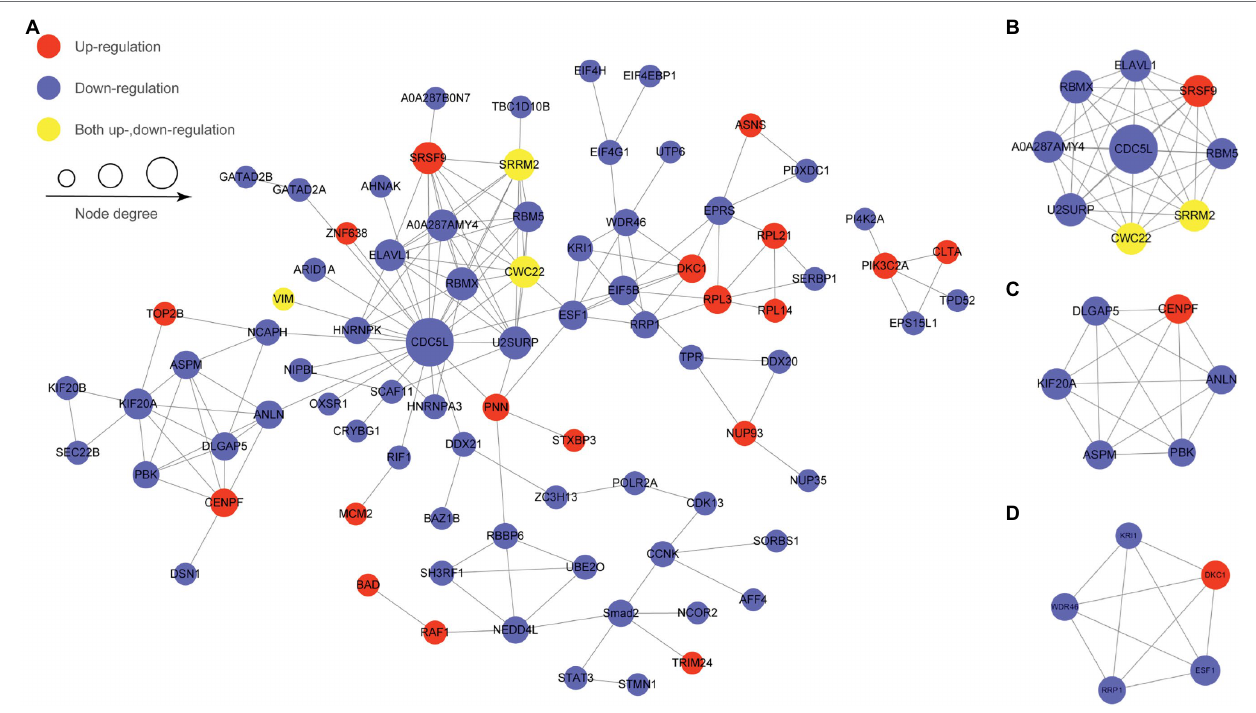
FIGURE 6 | Protein–protein interaction networks of differentially regulated phosphoproteins. Nodes represent the phosphorylated proteins, and edges represent interactions between phosphorylated proteins. The size of nodes represents the combined interaction scores. (A) The top 50 most closely interacting proteins interaction network. (B) MCODE cluster for spliceosome processes. (C) MCODE cluster for mitotic processes. (D) MCODE cluster for ribosome